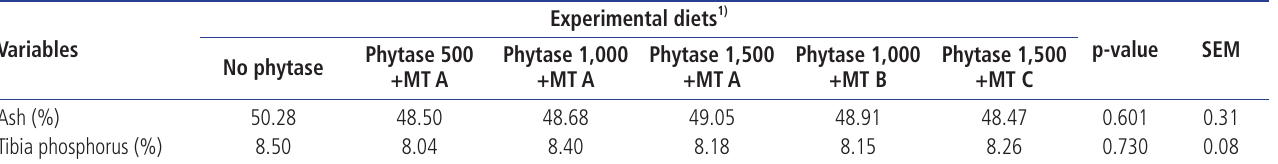
Table 6. Tibia ash and phosphorus content in defatted tibia of broilers at 21 days of age fed diets with different levels of phytase Variables